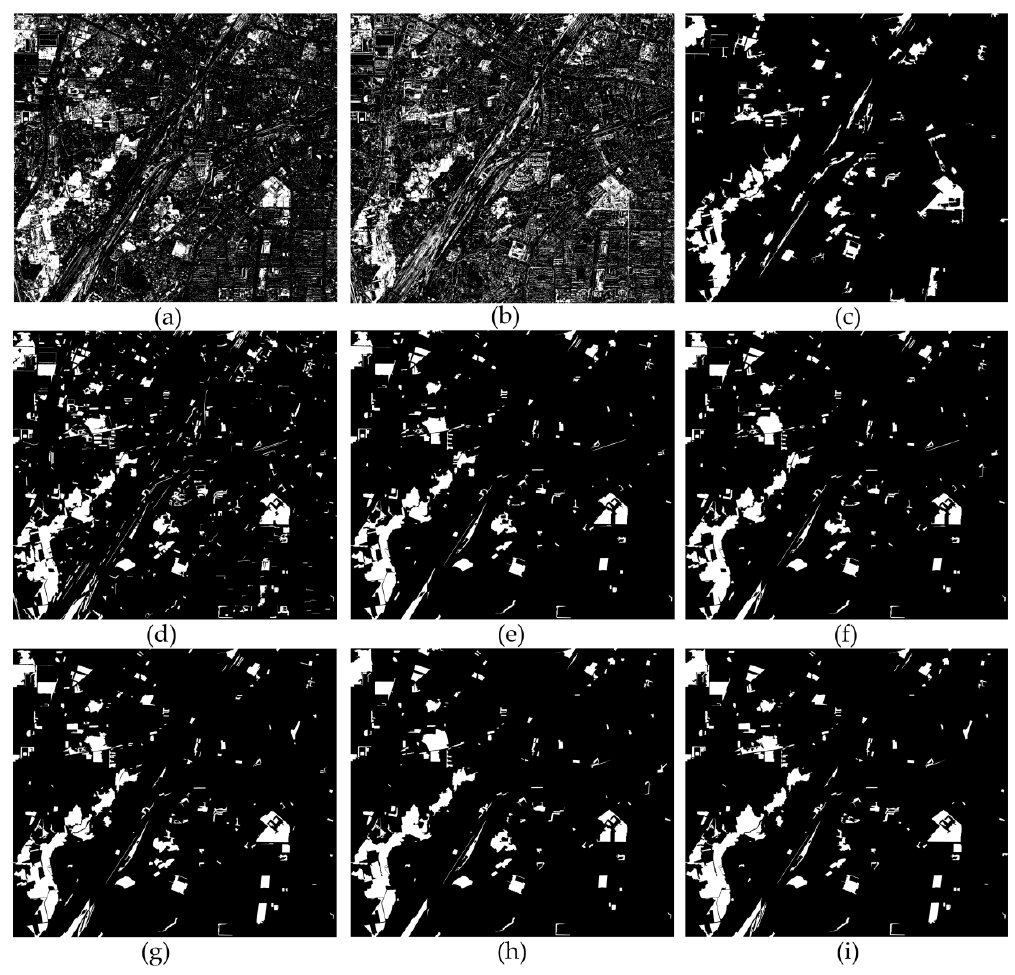
Figure 18. Comparison of different methods for DS2. ( a ) NCIA; ( b ) PCA- k -means; ( c ) OCVA; ( d ) RoF-scale 136; ( e ) RoF-scale 206; ( f ) RoF-scale 244; ( g ) ELM-MV; ( h ) RF-MV; ( i ) RoF-MV. Table 3. Performance comparison of different approaches for DS2.